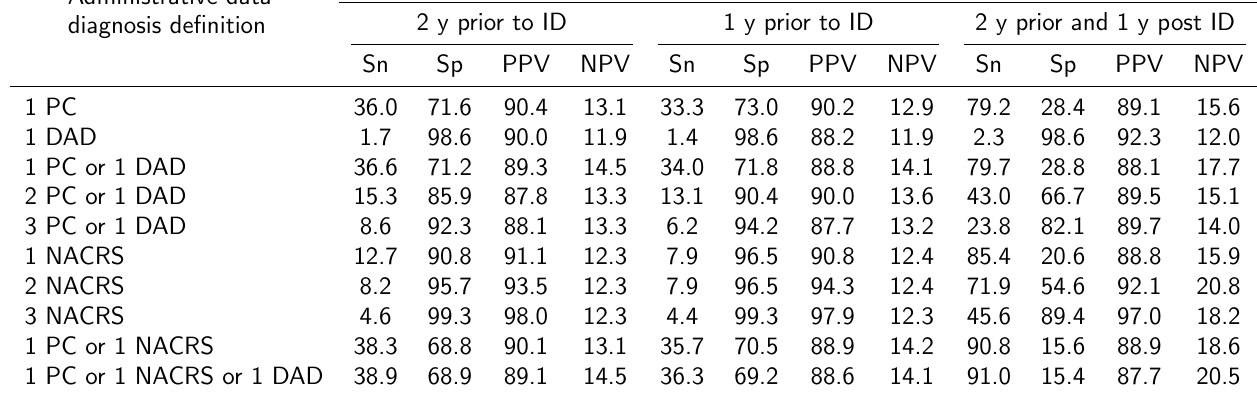
Table 3: Sensitivity, specificity, and predictive values for claims-based administrative ICD code combinations to identify sleep disorders (includes any ICD code identifying a sleep